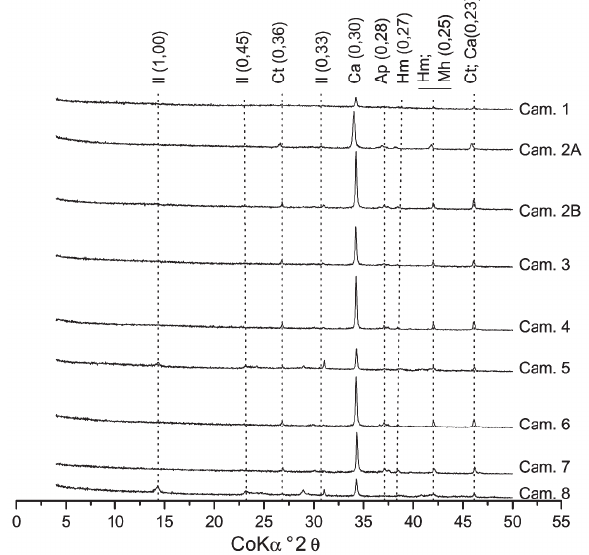
Figura 2. Difratogramas de raios-X da fração argila natural do solo da Lapa do Boquete. Il: illita; Ct: caulinita; Ca: calcita; Hm: hematita; Mh: maghemita; e Ap: apatita.